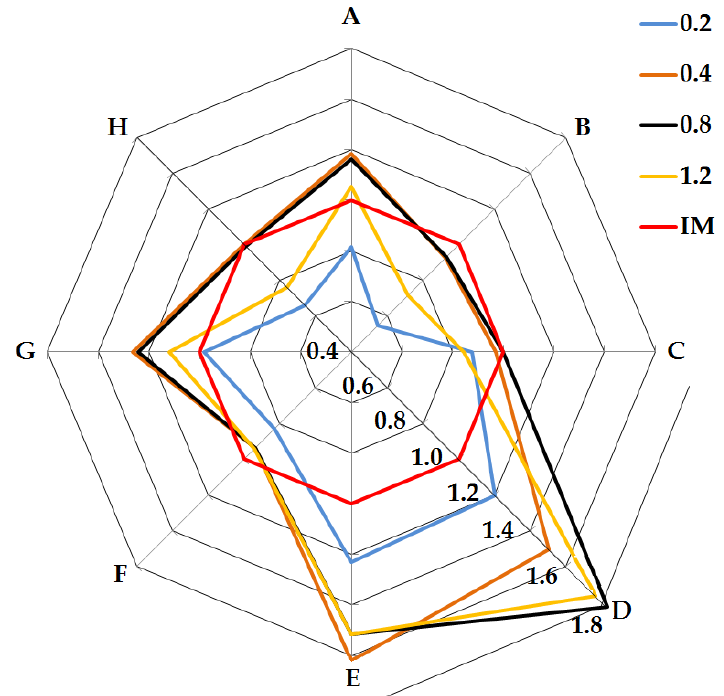
Figure 15. Comparison of mechanical properties of samples with a solid structure (injection mold- ing) and 3D-printed samples. A—Young’s modulus; B—tensile strength; C—elongation; D—impact strength; E—impact tensile strength; F—apparent density; G—specific modulus; H—specific tensile strength.